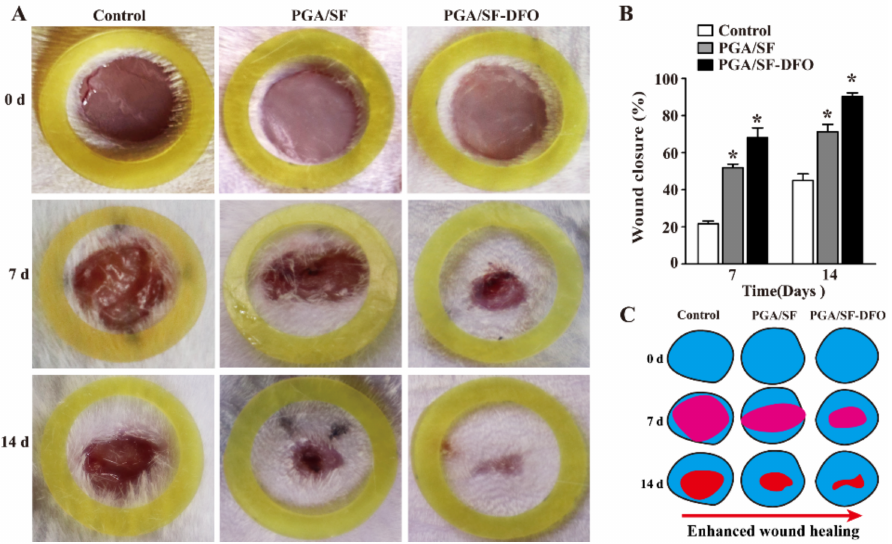
Figure 6. Diabetic wound healing evaluation of PGA/SF-DFO scaffolds. ( A ) Digital photographs of the wounds. ( B ) Quantification of the wound closure by Image J software. ( C ) Schematic diagram of wound healing at days 0, 7, and 14 after injury. Asterisks (*) indicate statistical significance, ( p <